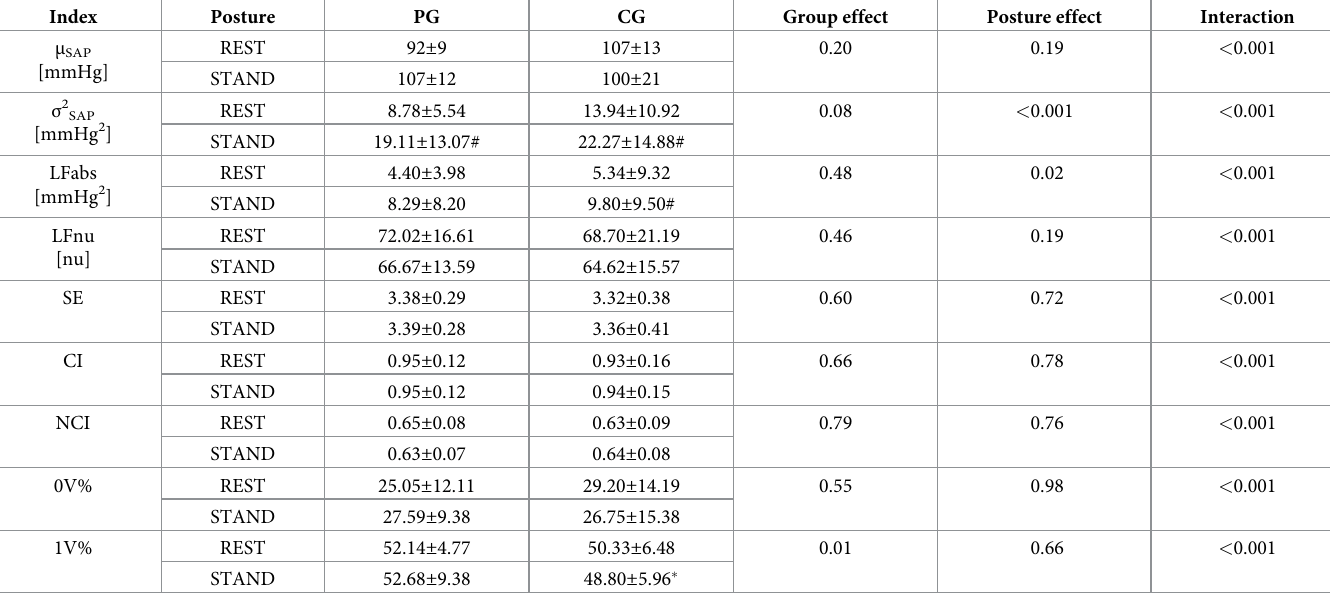
Table 3. SAP variability markers assessed in PG and CG via time, frequency, information and symbolic analyses.